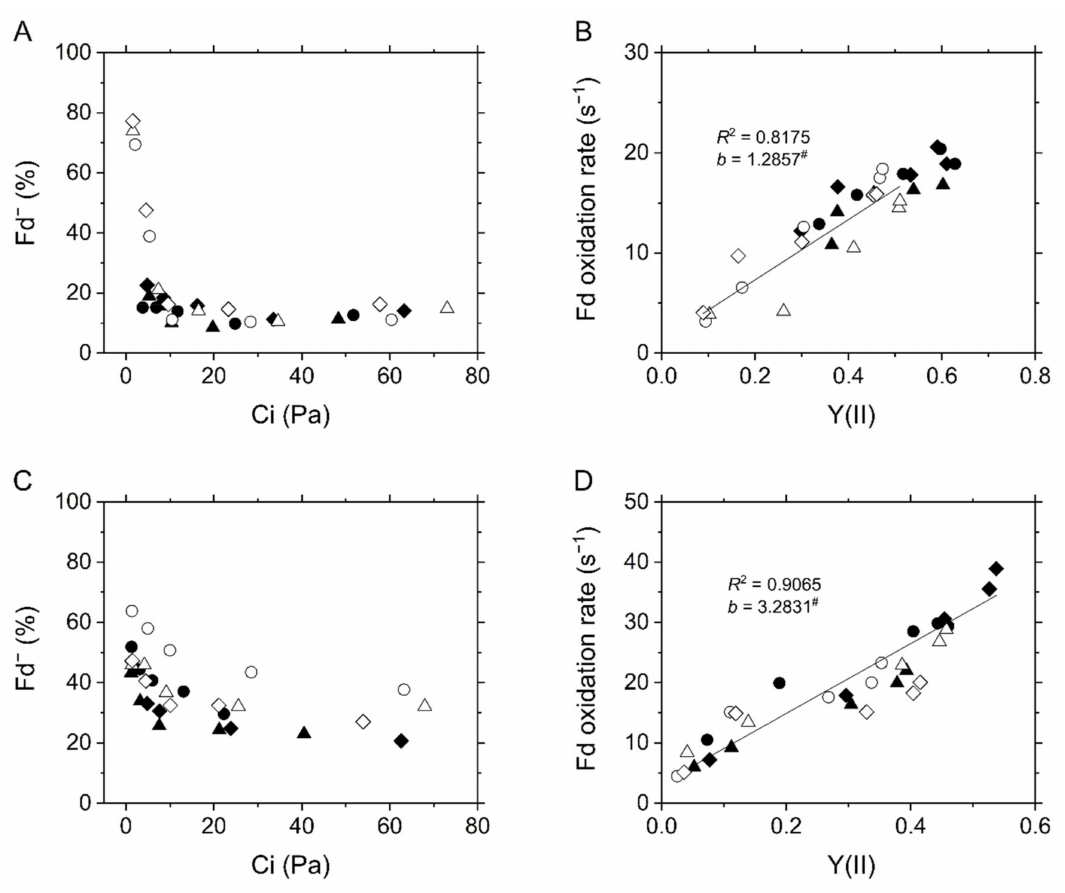
Figure 7. In vivo measurement for the redox state of ferredoxin (Fd) in the C 3 plant mustard ( A , B ) and the C 4 plant maize ( C , D ). ( A , C ) The Fd reduction during the steady-state photosynthesis at various intercellular CO 2 partial pressures (Ci). ( B , D ) Relationship of Fd − oxidation rate with effective quantum yield of PSII, Y(II), at various Ci. Experiments were conducted independently three times as shown in different symbols (biological replicates) at 21 kPa (closed symbols) and 1 kPa O 2 (open symbols). Solid lines represent the estimated linear regressions of the data at 1 kPa ( B ) and 21 kPa O 2 ( D ), respectively ( R 2 , coefficient of determination). The y -intercepts ( b ) were tested based on the null hypothesis: # p >